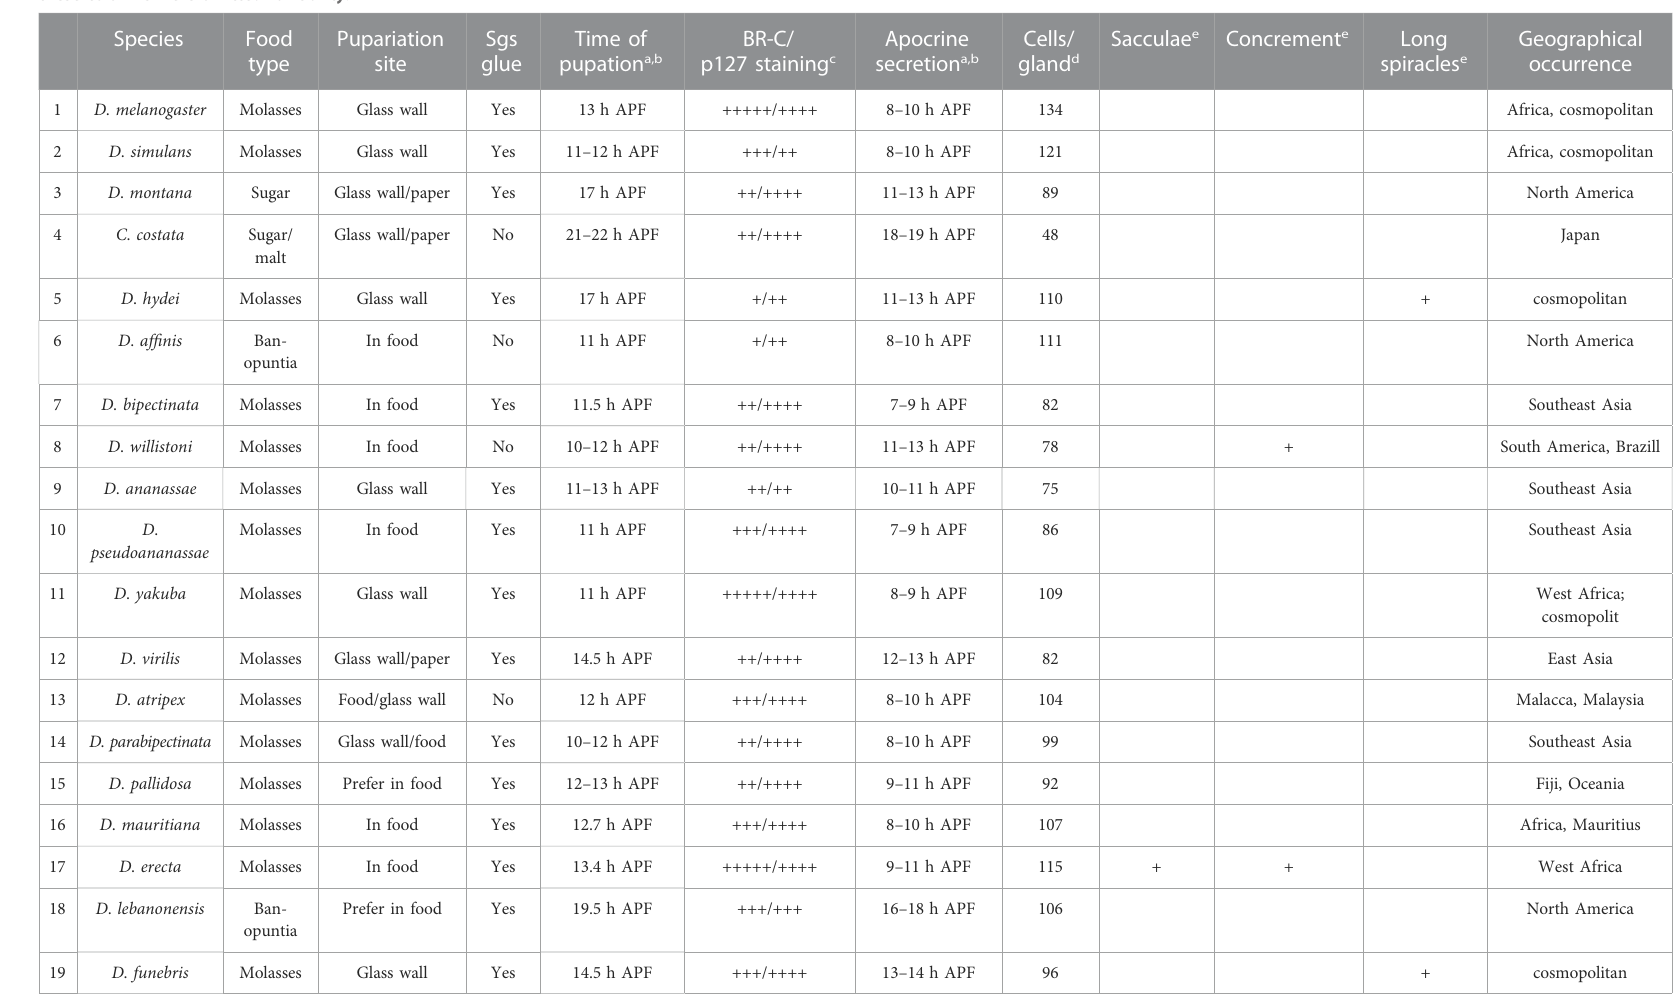
TABLE 1 Summary data on the activities and developmental events occurring near pupation and pupariation in 32 species of Drosophila and two non-drosophilid species. The table lists the time of pupation and apocrine secretion, whether Sgs-granules and glue are present, the relative intensity of detection of BR-C and p127 proteins using D. melanogaster-speci fi c antibodies, the species ‘ preferred site of pupariation, the typeoffoodusedinthisstudy, thenumberofsecretory cellsperSGlobe,whethercollector sacculae,post-apocrine concrements, andlonganteriorspiracles arepresent,andthegeographical occurrence (originally reported or currently known) of a particular species. The times of pupation and apocrine secretion for a species are the range of times seen in three sets of observations, each having a minimum of 30 animals. The number of secretory cells for a species is the arithmetic means of cell counts obtained using a fl uorescent microscope and a 20× objective lens for a minimum of 15 pairs of SGs from each species, in triplicates. Abbreviations: APF = after puparium formation; Legend for symbols: Relative intensity of fl uorescence is depicted by the number of plus (+) signs for each of the proteins, where fi ve pluses (+++++) represents the strongest signal, asignal equal tothatfound inD.melanogaster, andasingle plus(+)indicates the weakest signal.Inadditional columns asingleplus (+)indicates thepresence ofcollector sacculae,the presence of concrements, and the formation of long spiracles during pupariation, respectively. An empty cell in these columns indicates the absence of collector sacculae, concrements, or long spiracles. Negative signs ( − ) in these columns were omitted for